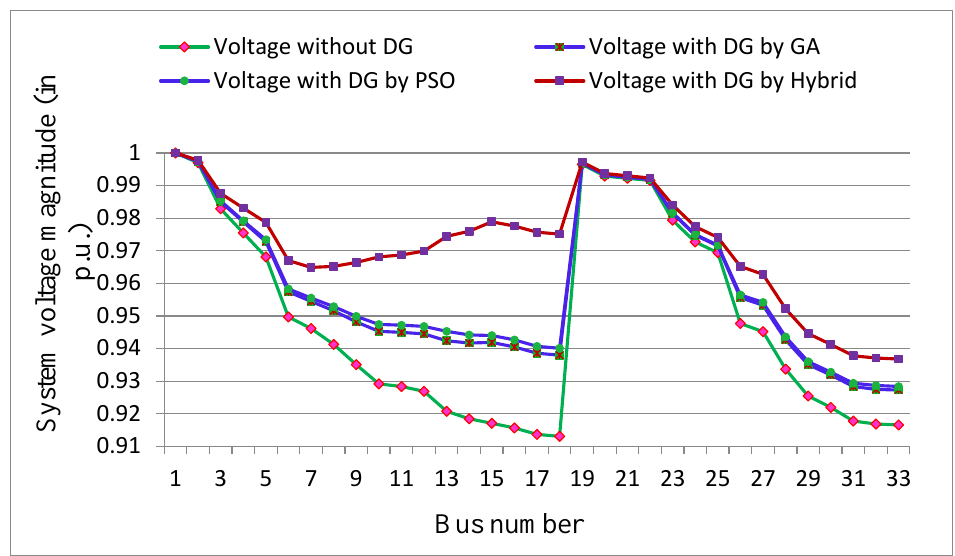
Figure 6. System voltage profile for scenario-1 with and without DG by PEM based method in case of GA, PSO and hybrid GA-PSO based optimization technique.